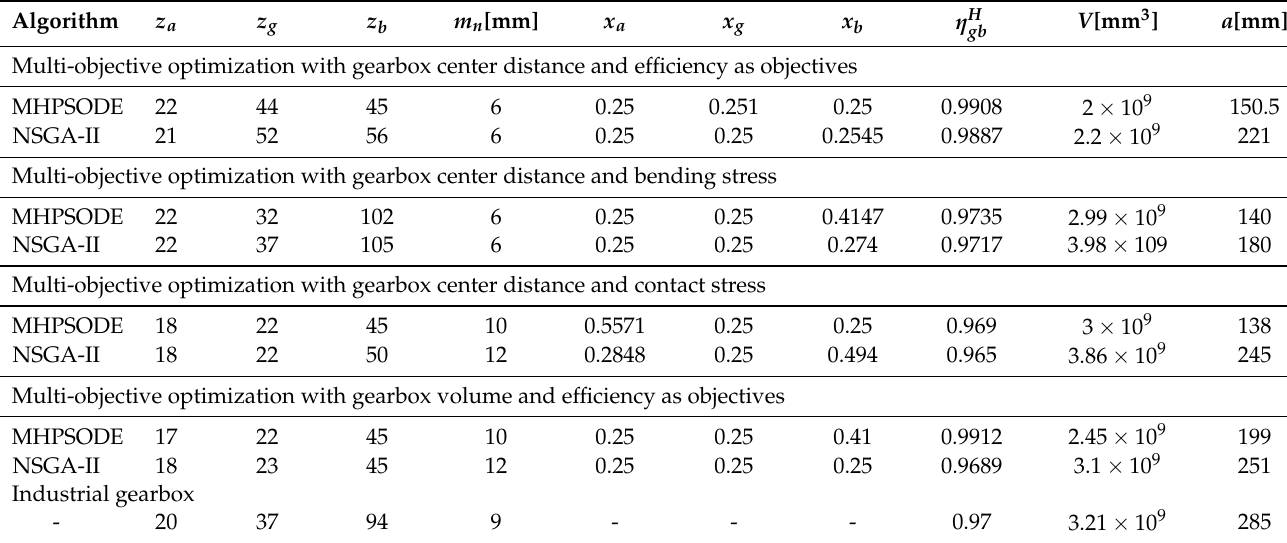
Table 2. The obtained values of design variables for the considered MOO problem of planetary gearbox and parameters of the reference industrial